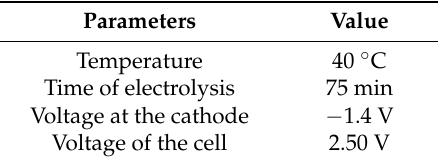
Table 9. Best process parameters of the phase of gold